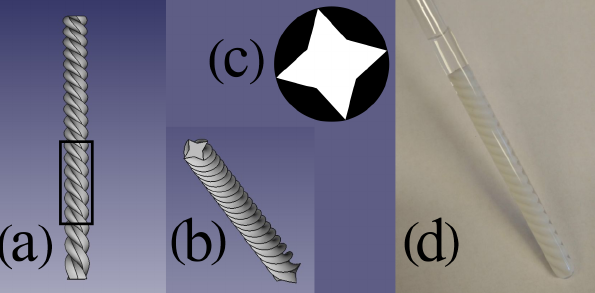
Figure 1. Phantom used for the spin noise imaging experiments. (a) Rendered image of the phantom from a front perspective. (b) Rendered image of the phantom from a front/top perspective. (c) Typical cross section, which is a star-shaped octagon (white). This shape was rotated around and translated along the Z axis si- multaneously to form the 3D phantom object. (d) The 3D printed phantom from a polylactide (PLA) polymer inserted into a standard 5mm NMR tube filled with H 2 O / D 2 O (9:1). The black frame in panel (a) indicates the sensitive area within the NMR spectrometer’s probe.